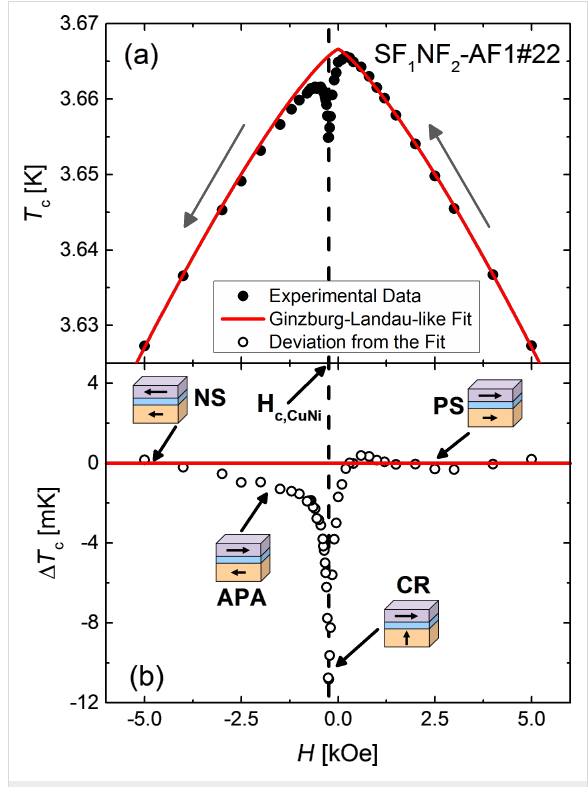
Figure 6: (a) Superconducting transition temperature T c of SF 1 NF 2 - AF1#22 as a function of the applied magnetic field H . The direction of the variation of the applied field is given by arrows, the solid red line shows a fit to a Ginzburg–Landau-like behavior (for details see the text). (b) Deviation, Δ T c , calculated between the experimental data and the fit. The pictograms show the magnetic configurations of the system in accordance with the magnetic measurements in Figure 4. The maximal suppression at crossed configuration of the magnetic layers is evaluated as Δ T c,max . Here, H c,CuNi is the coercive field of the Cu 41 Ni 59 alloy